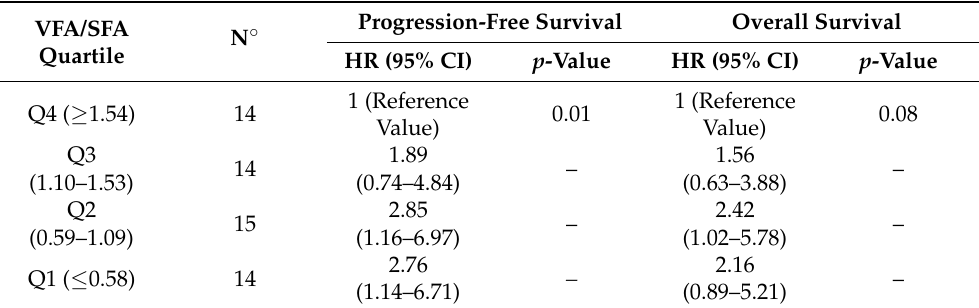
Figure A3. Kaplan–Meyer curves according to the VFA/SFA ratio: ( a , b ) progression-free and overall survival stratified by quartiles, respectively. Table A1. Univariate analysis for progression-free and overall survival according to VFA/SFA ratio stratified by